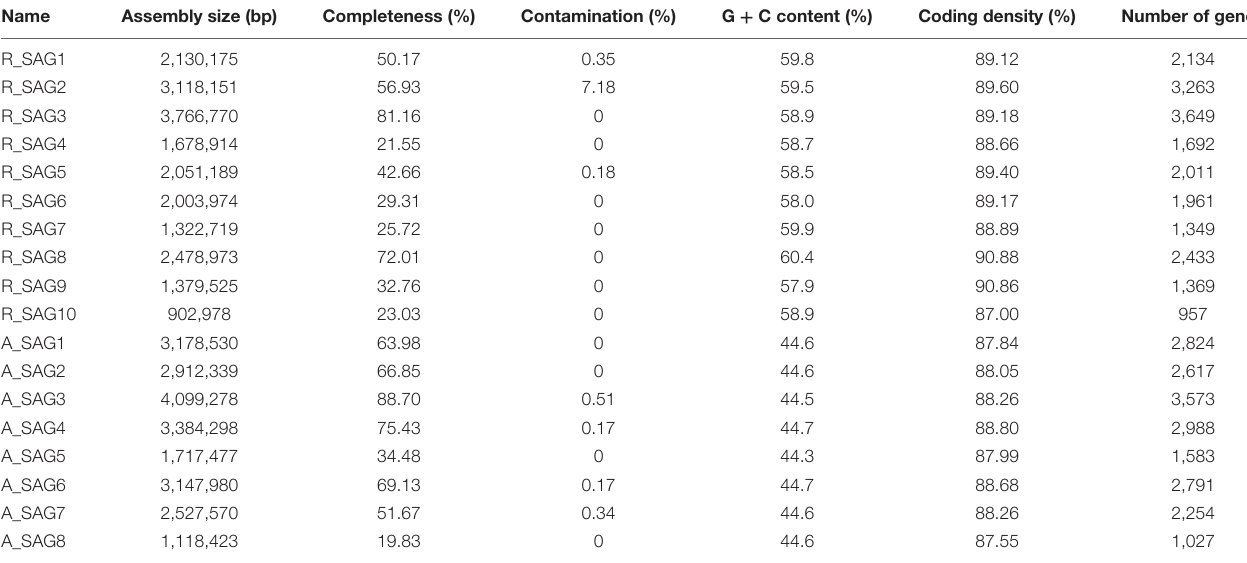
TABLE 1 | Genomic characteristics of the Roseobacter and Alteromonas SAGs recovered from the Mariana Trench a .